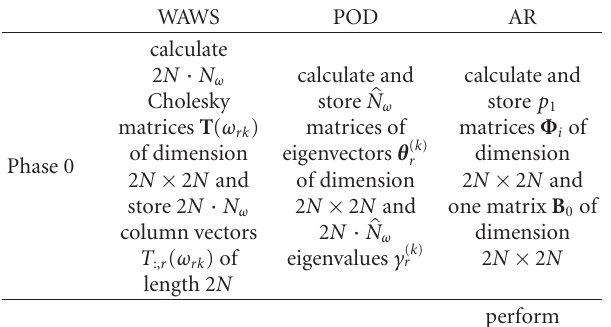
Table 1: Two-steps implementation of the considered simulation methods and corresponding memory allocation for a 2N -variate process (the symbol ∝ denotes proportionality).